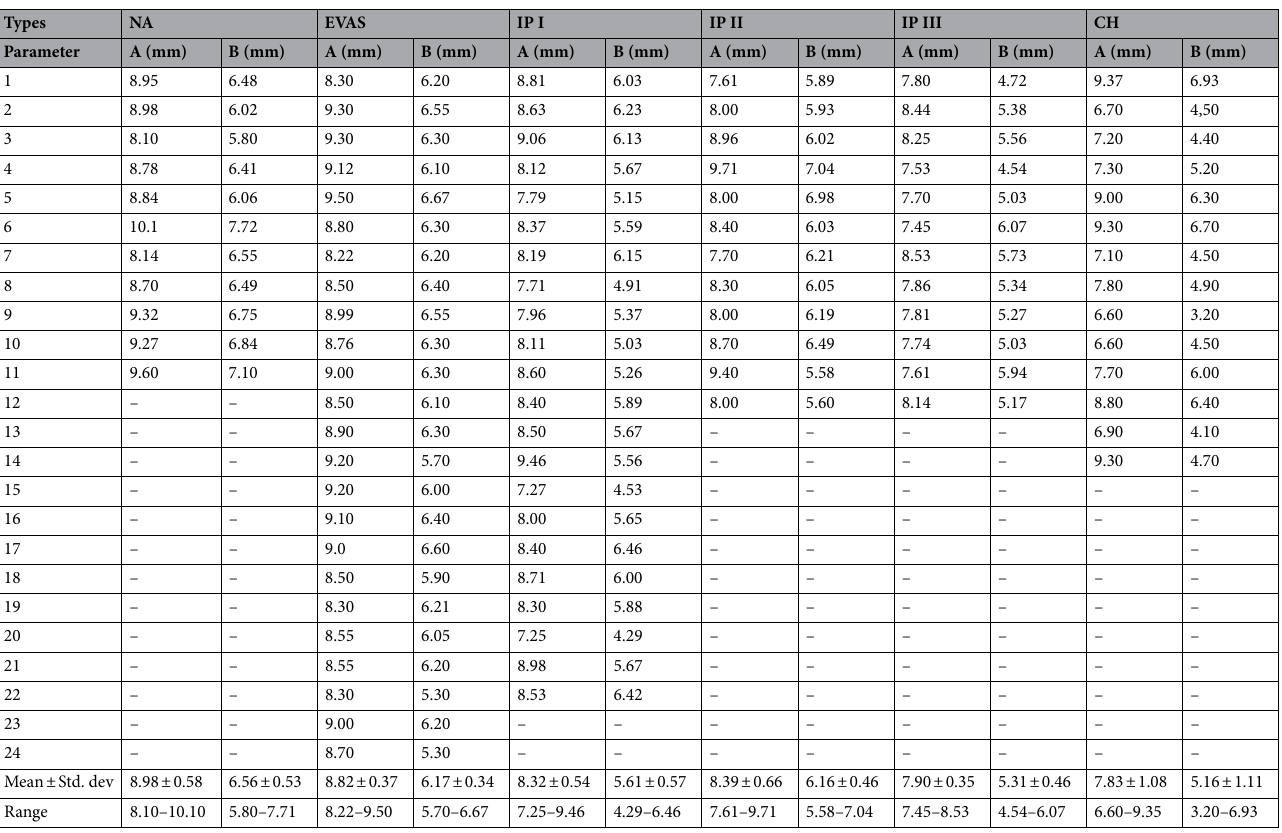
Table 1. A- and B-values measured from all the anatomical types. NA normal anatomy, EVAS enlarged vestibular aqueduct syndrome, IP incomplete partition type 1, IP II incomplete partition type 2, IP III incomplete partition type 3, CH cochlear